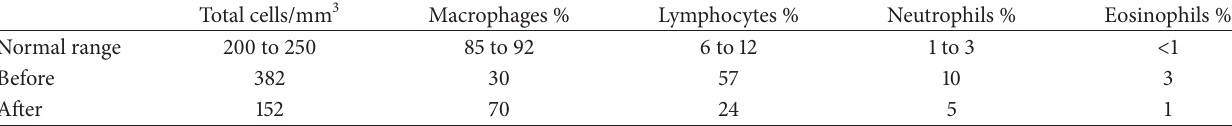
Table 1: Global and specific cytology of bronchoalveolar lavage fluid, segmental and sequential (evolution), after 10